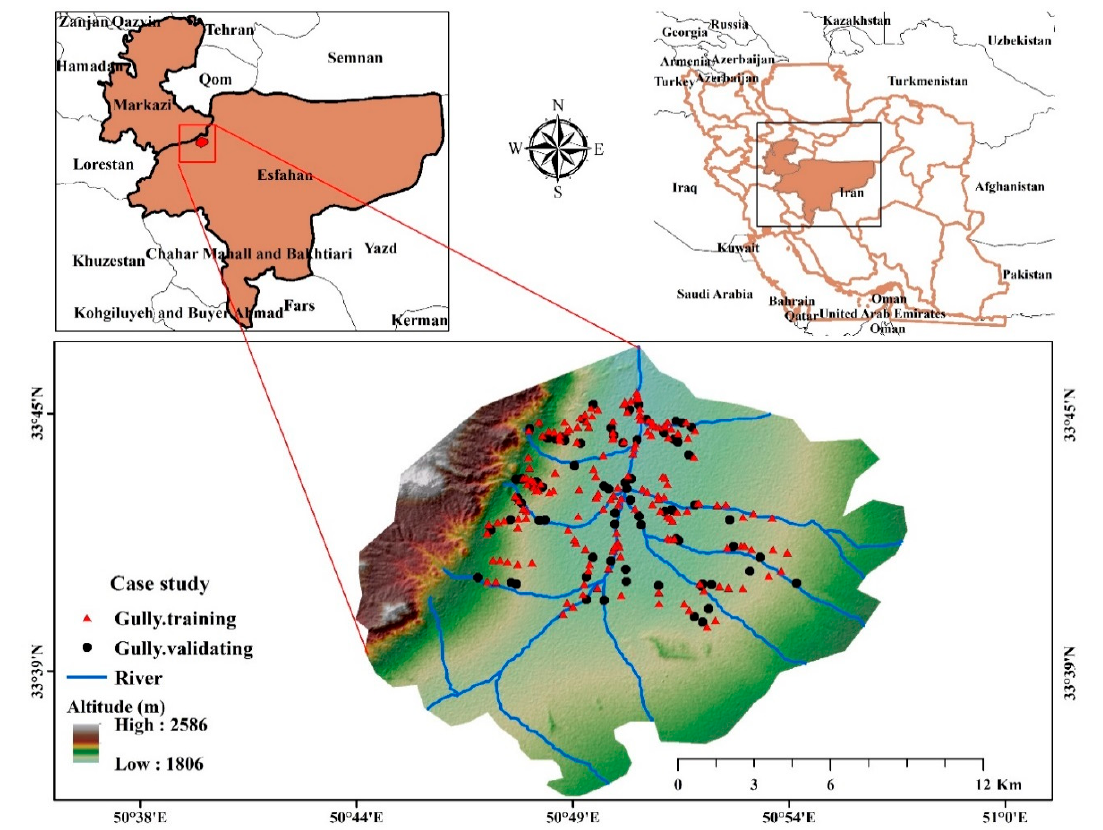
Figure 1. Location of the study area and model training and validating gullies. 116